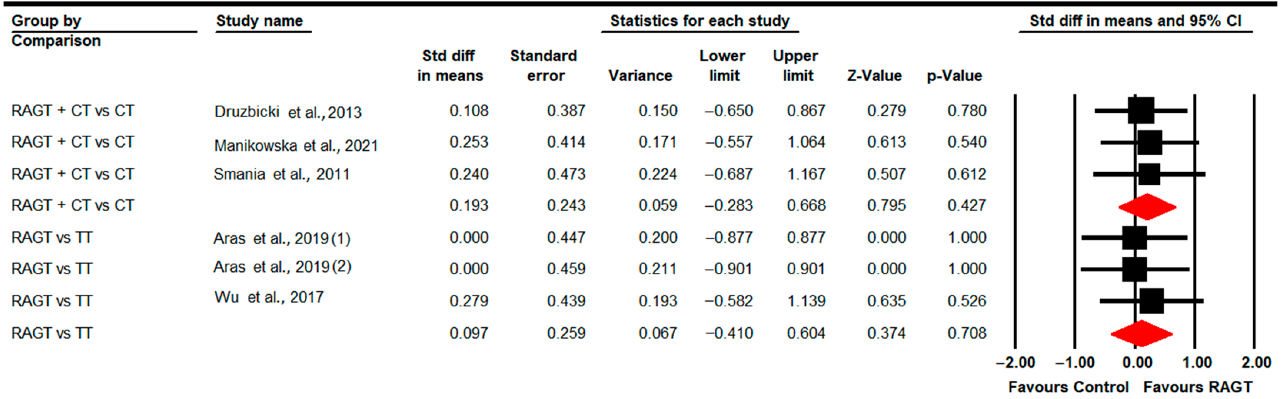
Figure 3. Forest Plot of Step Length (Post-Intervention Assessment) [79,80,83,85,88].